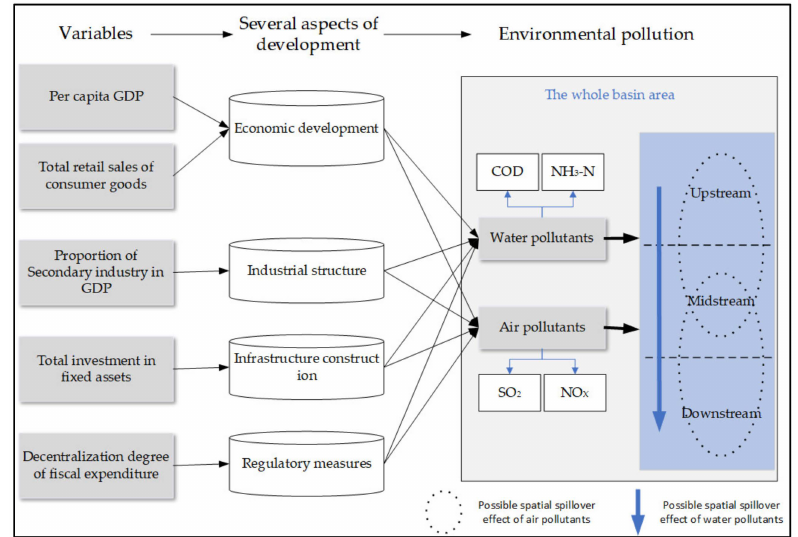
Figure 2. The driving mechanism of environmental pollution in the